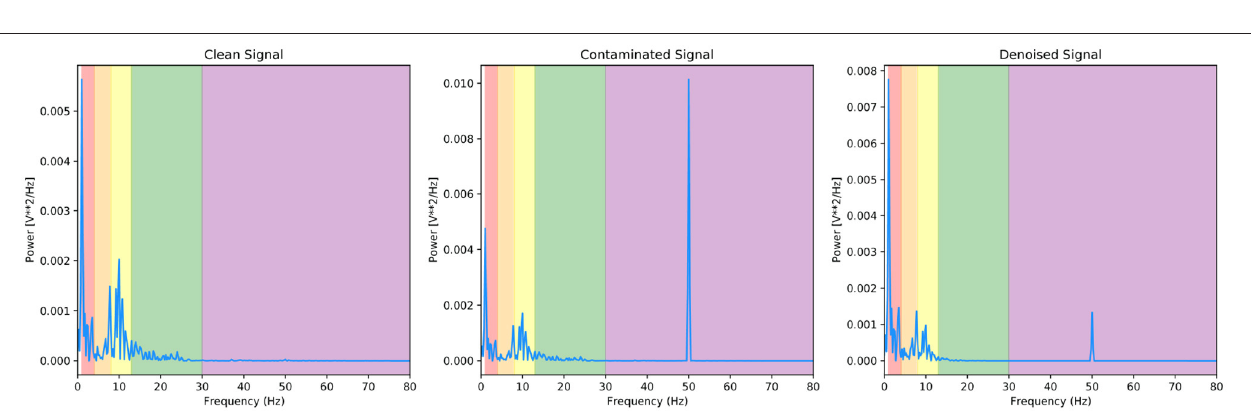
FIGURE 11 | PSD of the EEG-50 signals shown in Figure 10 (right) with corresponding EEG bands.